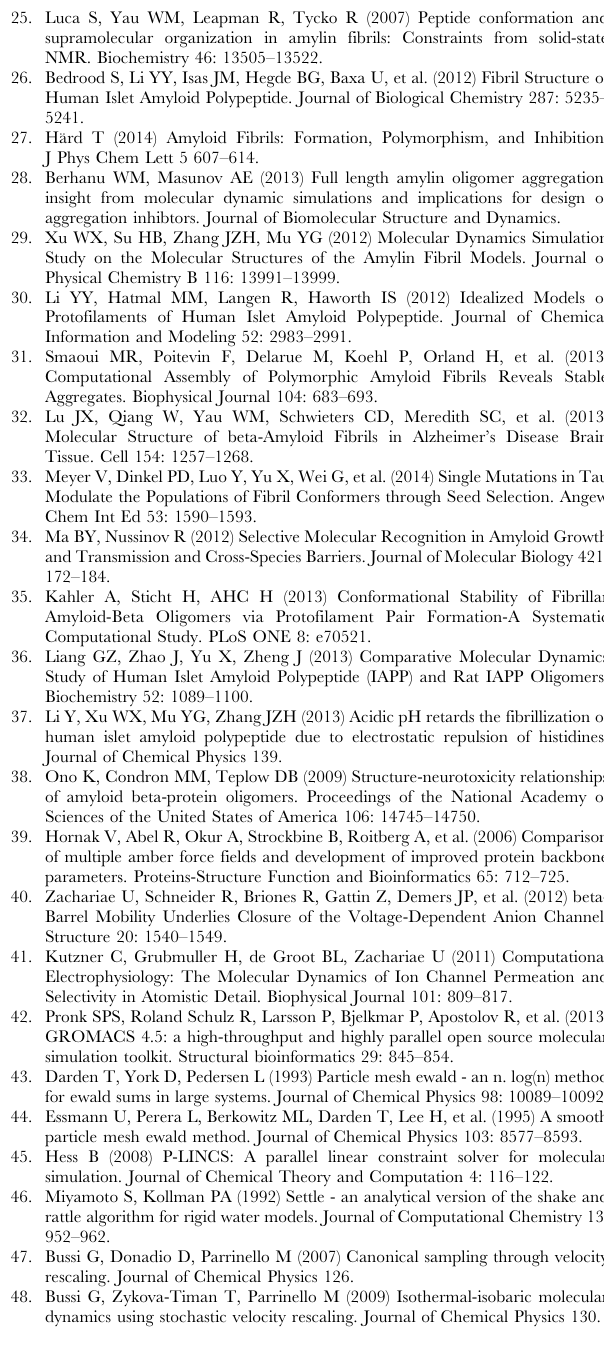
Figure S1 The detailed structural changes for the three trajectories in each model, at the conclusion of 300 ns of molecular dynamics in explicit solvent. The initial structures are depicted in cyan. Different colors mark rat (red) and human amylin (green). Root-mean-square-deviation values calculated for each peptide with respect to the start configurations are included in